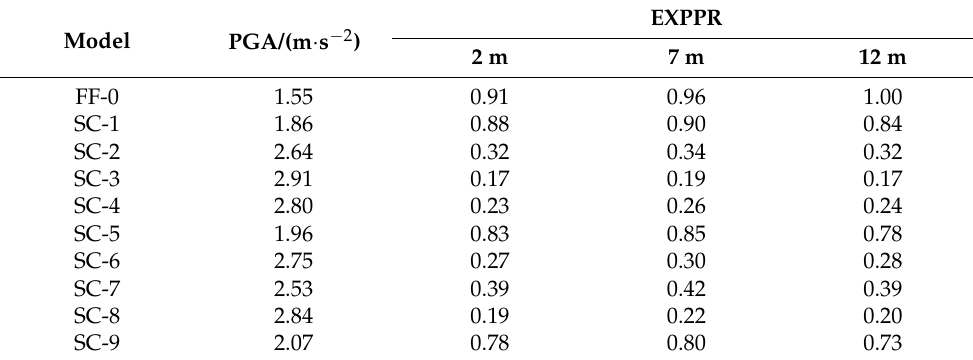
Figure 4. Time histories of excess pore pressure ratio. Table 4. Peak values of ground acceleration and EXPPR of simulation